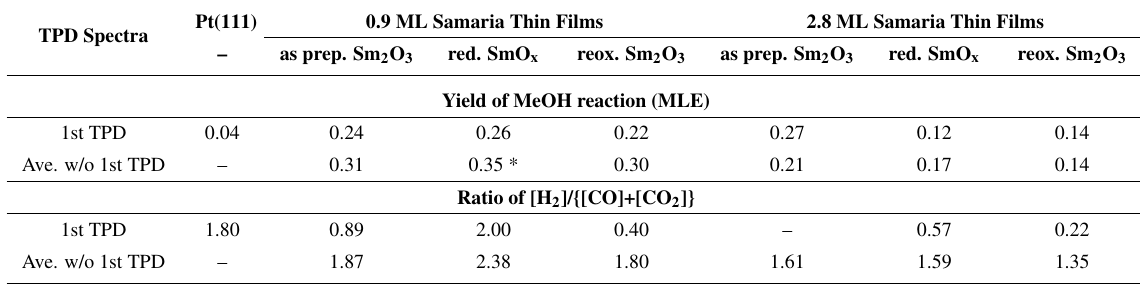
Table 1. Summary of the overall reactivity for the MeOH reaction on Pt(111), the 0.9 ML SmO x /Pt(111), and the 2.8 ML SmO x samples. Yields of methanol reaction and ratios of [H 2 ]/{[CO] + [CO 2 ]} estimated from TPD spectra on each samples. Yields of methanol reaction are defined by [CH 3 OH] = [CO] + [CO 2 ] except on the 0.9 ML reduced film (marked *), 0.35 MLE is estimated by [CH 3 OH] = 2 [H 2 ] because a fraction of carbon and oxygen remains on/in the reduced film.